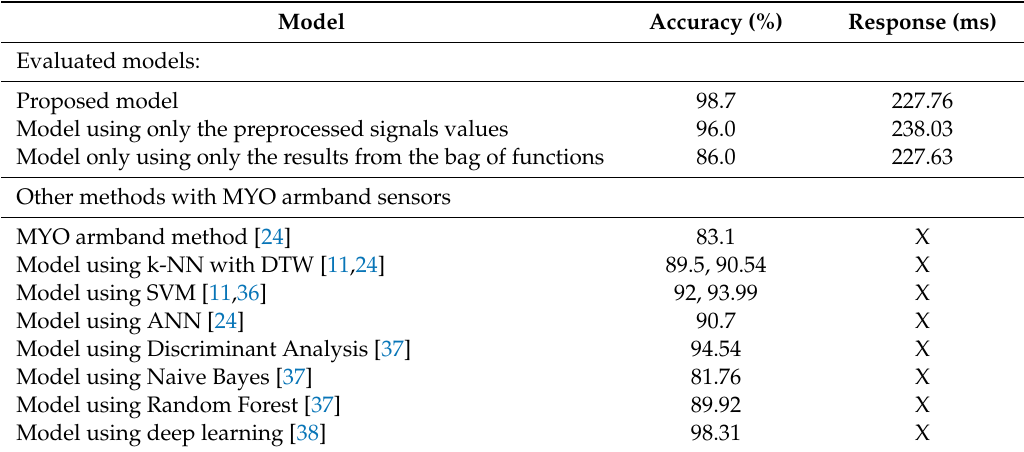
Table 2. The proposed model compared with other models.